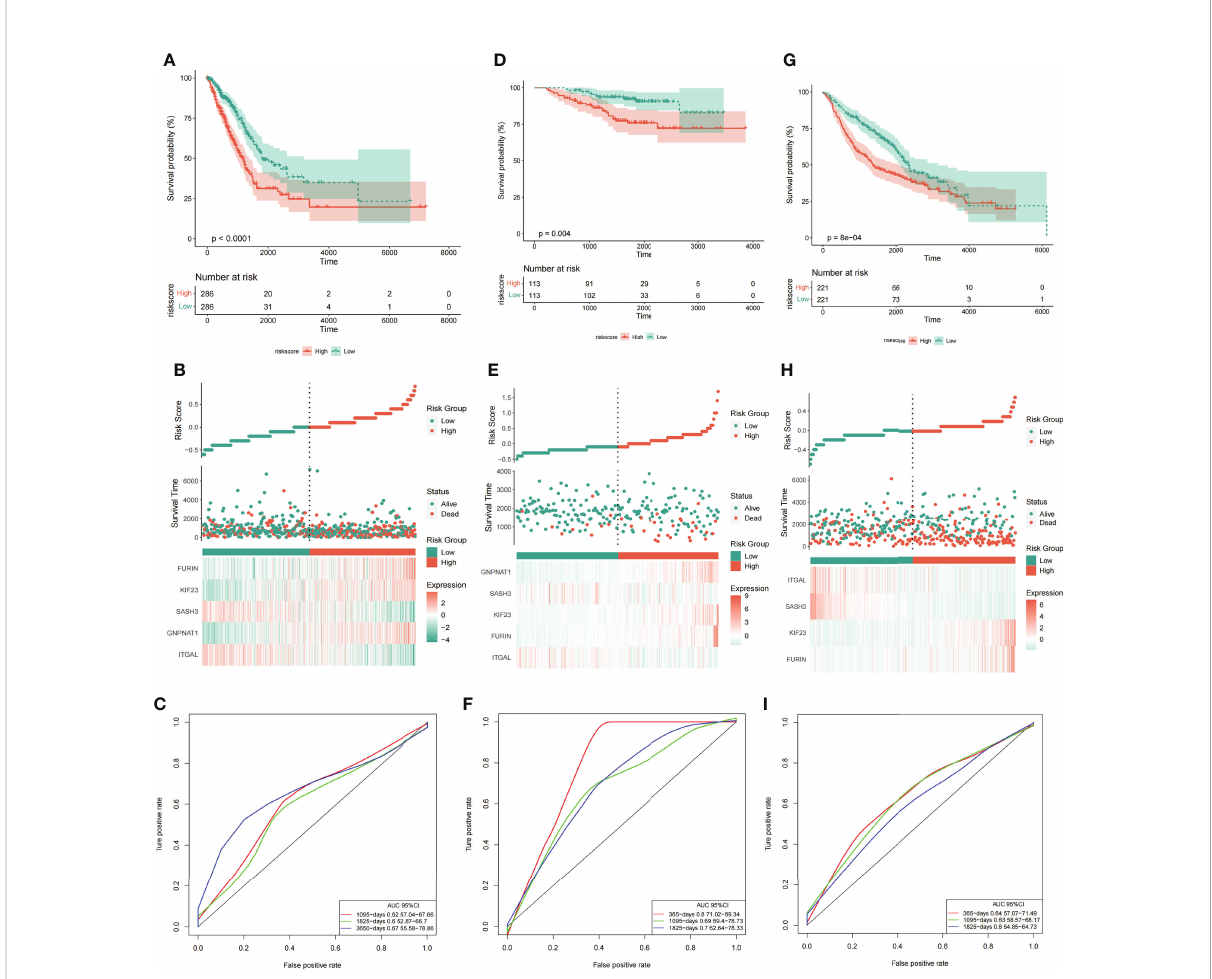
FIGURE 7 Risk score could predict the outcome of LUAD patients. Survival analysis (A, D, G) , risk score and grouping of samples (B, E, H) , and ROC curve (C, F, I) in the training set (TCGA) and two validation sets (GSE31210 and GSE68465). From left to right are the TCGA, GSE31210 and GSE68465 datasets